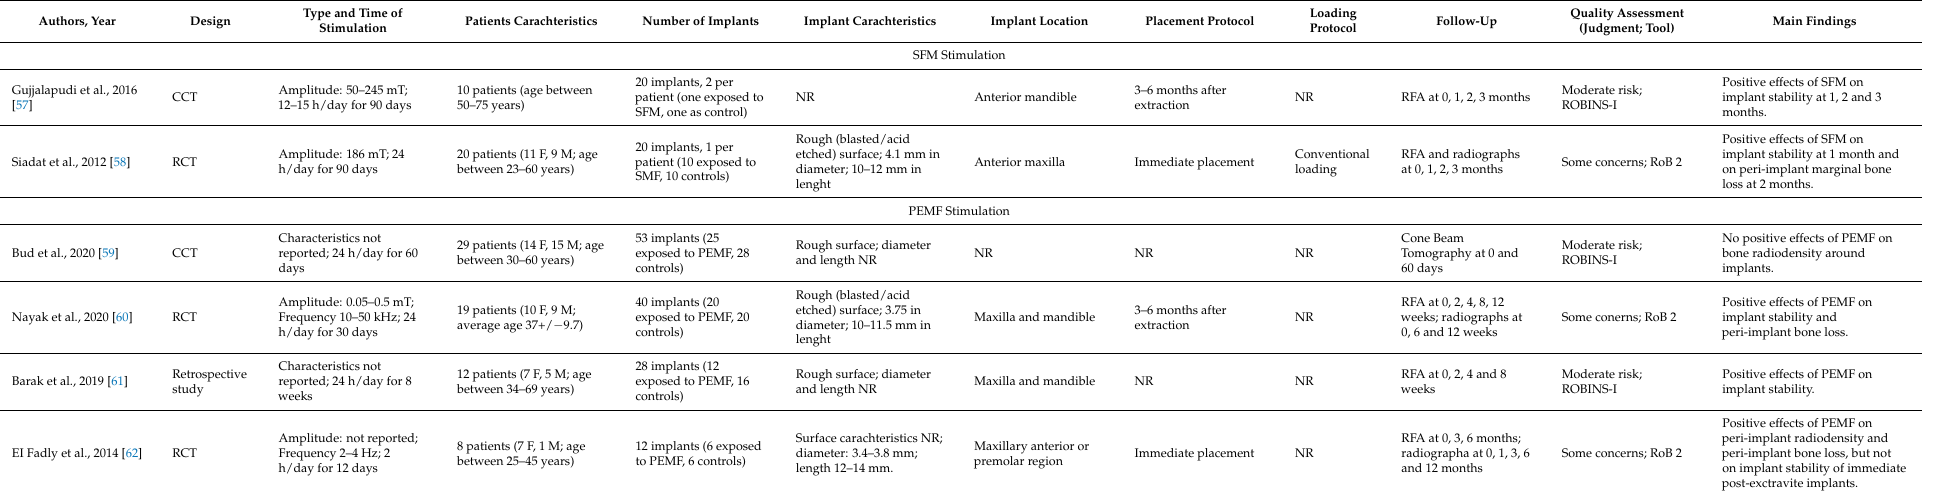
Table 4. Characteristics and main findings of the clinical studies